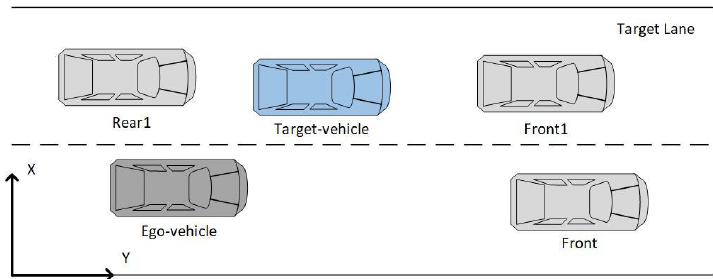
Figure 6. The five-vehicle cluster.